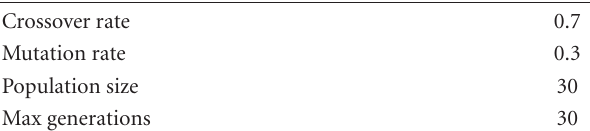
Table 4: GA parameters.